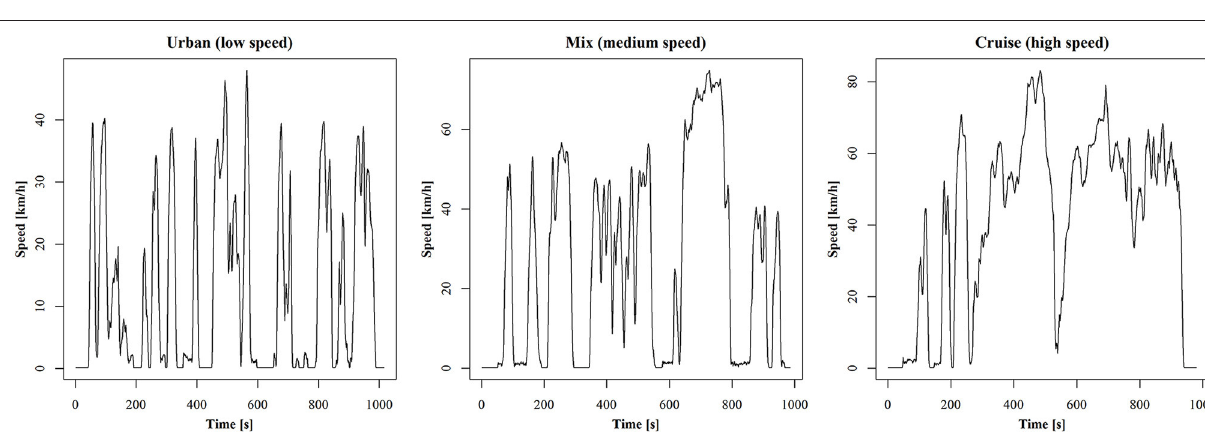
FIGURE 1 | Typical configuration of measurement equipment on a vehicle being measured.